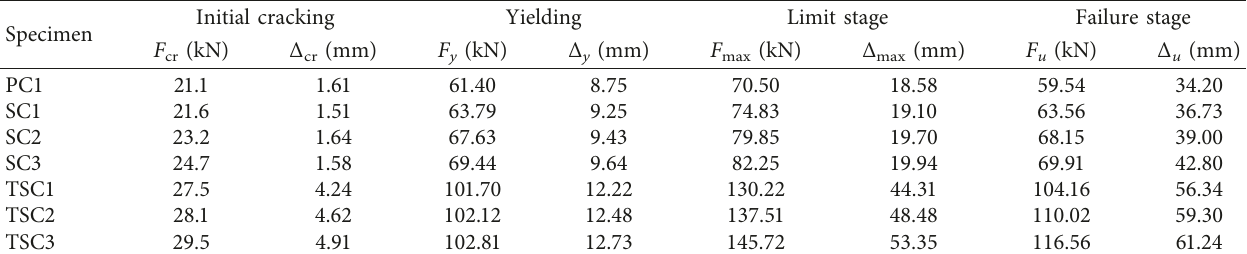
Table 5: Characterized points on the column